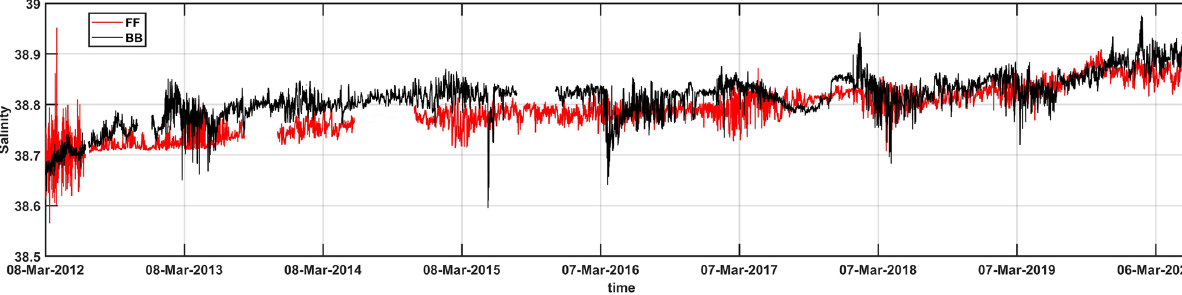
Figure 5. CTD Salinity records on the two mooring sites BB and